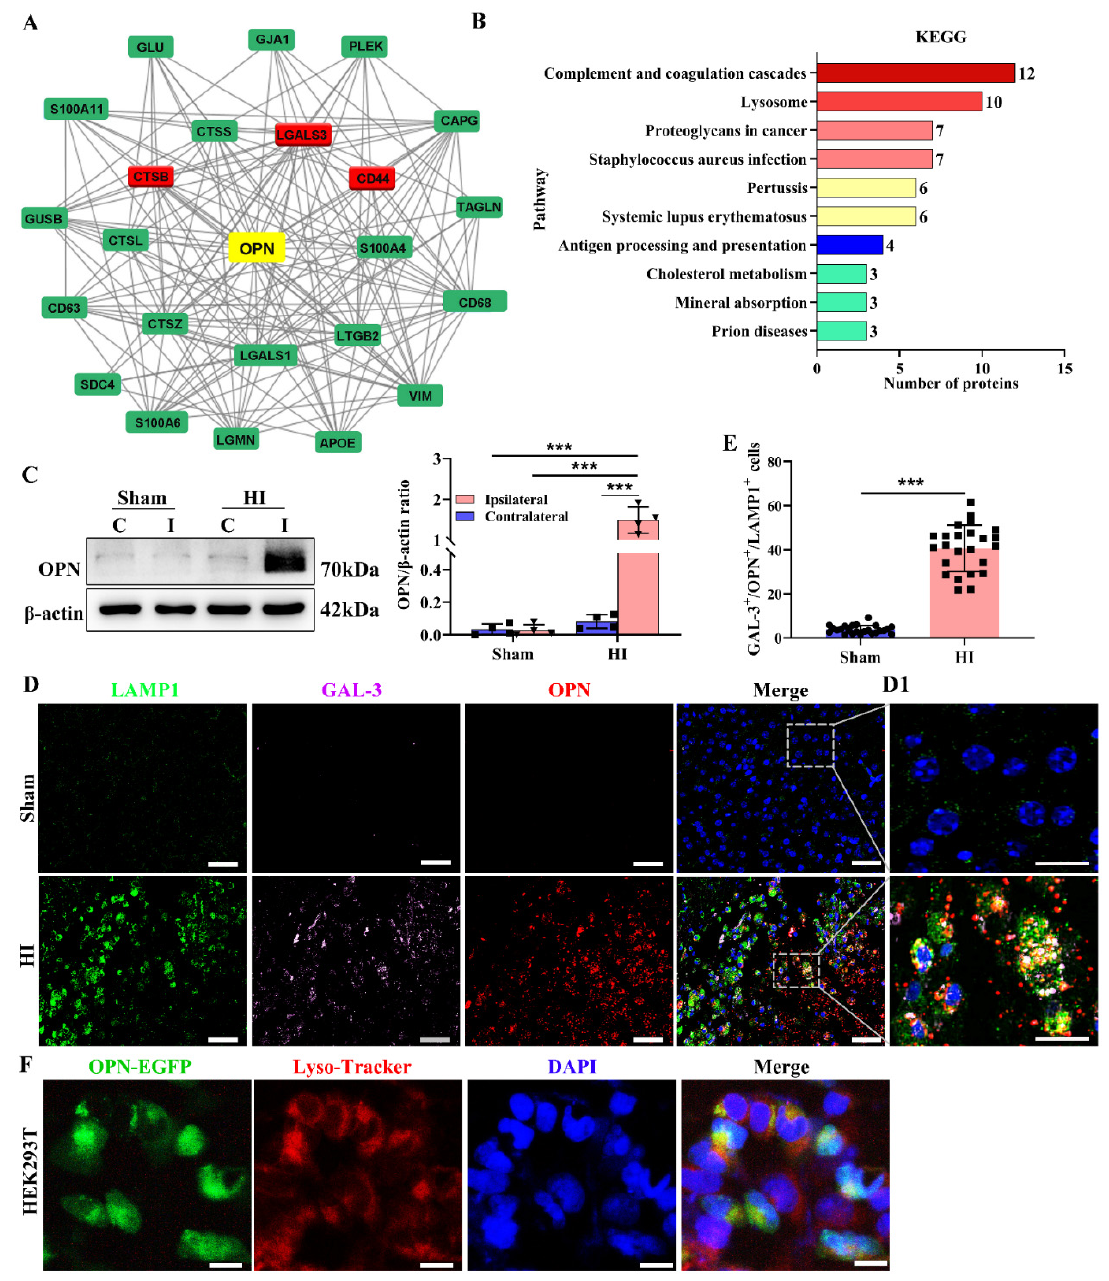
Figure 1. Increased expression of OPN was colocalized with the lysosome. ( A ) Interaction analysis of OPN-related target proteins. ( B ) Bar diagram of KEGG pathways from the comparison between the Sham group and HI group. ( C ) Western blot demonstrated upregulated OPN in ipsilateral regions (abbreviated as I) in the matching contralateral (abbreviated as C) region of HI and Sham group ( n = 4). All experiments were performed three times. ( D , E ) Immunofluorescence images revealing colocalization of LAMP1, GAL-3, and OPN at 3 days post-HI ( n = 4), Scale bar = 50 µ m; D1: Magnified views of boxed regions in ( D ) showing colocalization of LAMP1, GAL-3, and OPN. Scale bar = 20 µ m. ( F ) HEK293T cells were stably transfected with OPN-EGFP and labeled with Lyso-Tracker Red ( n = 6). Scale bar = 20 µ m. Values represent the mean ± SD, *** p < 0.001 according to one-way ANOVA with Bonferroni corrections in ( C ). *** p < 0.001 according to t -test in ( E ), contralateral; GAL-3, galectin-3; HI, hypoxia-ischemia; I, ipsilateral; KEGG, Kyoto encyclopedia of genes and genomes; OPN,